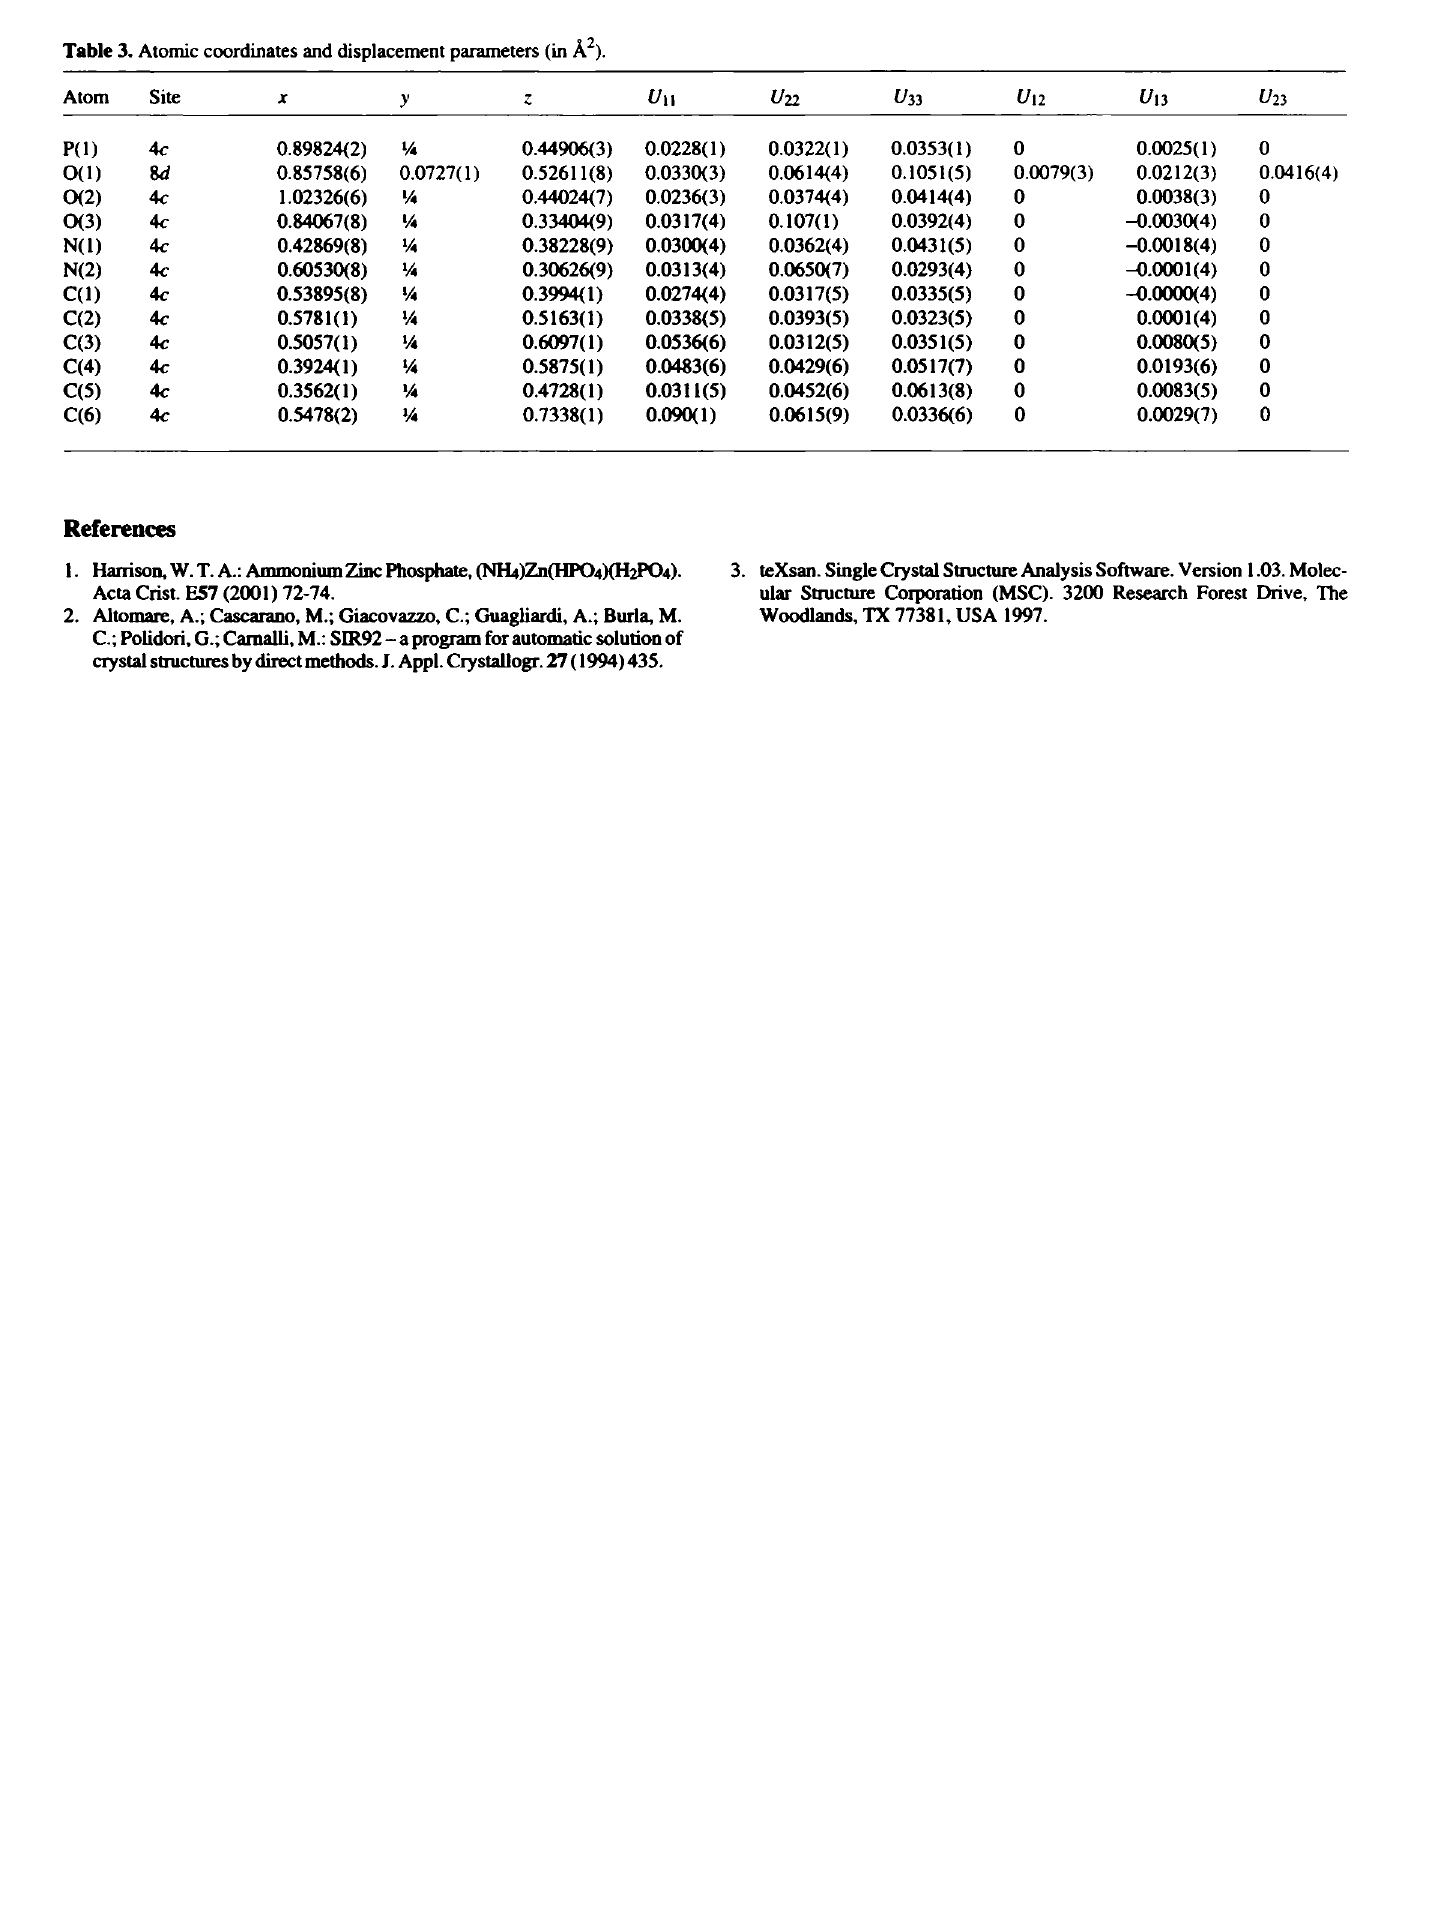
Table 3. Atomic coordinates and displacement parameters (in Â 2